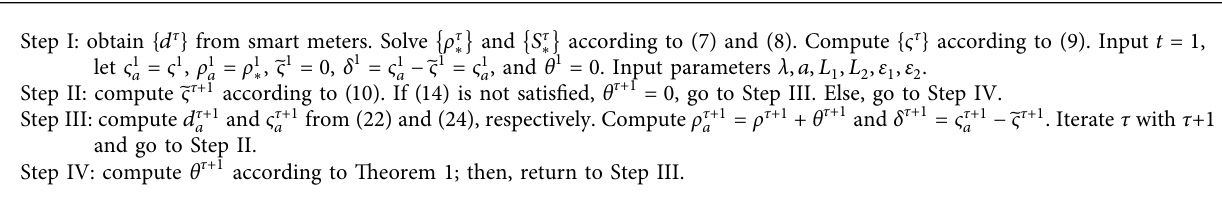
Table 3. The process of repeated-feedback adjustment